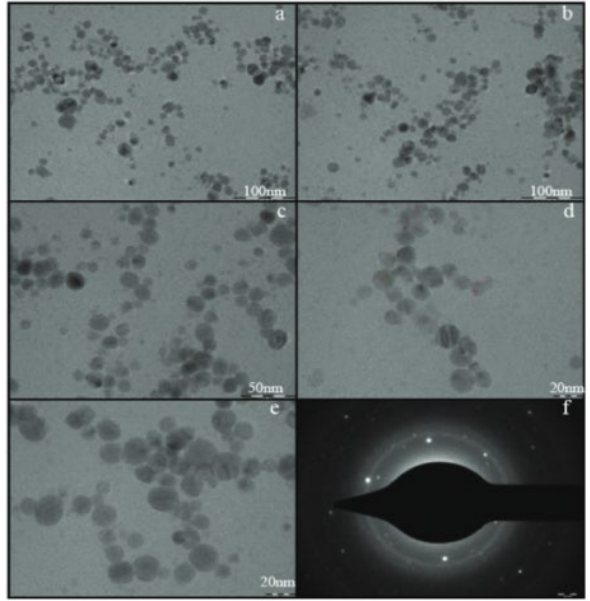
Figure 5. TEM images of silver oxide nanoparticles synthesized by Lactobacillus mindensis (low resolution images ( a – c ) and high resolution images ( d , e ). Selected area electron diffraction pattern ( f )). Reprinted from Ref. [52].